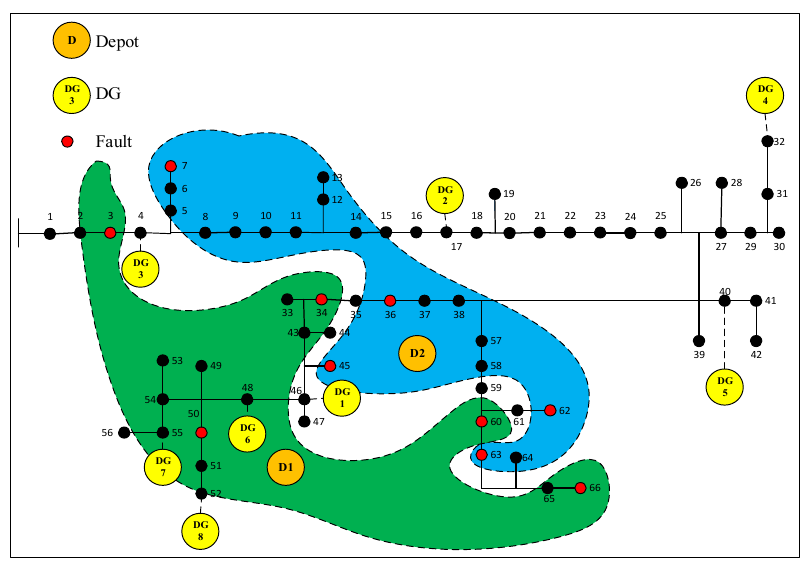
Figure 10. Outage clustering in Iranian 66 bus power distribution feeder.